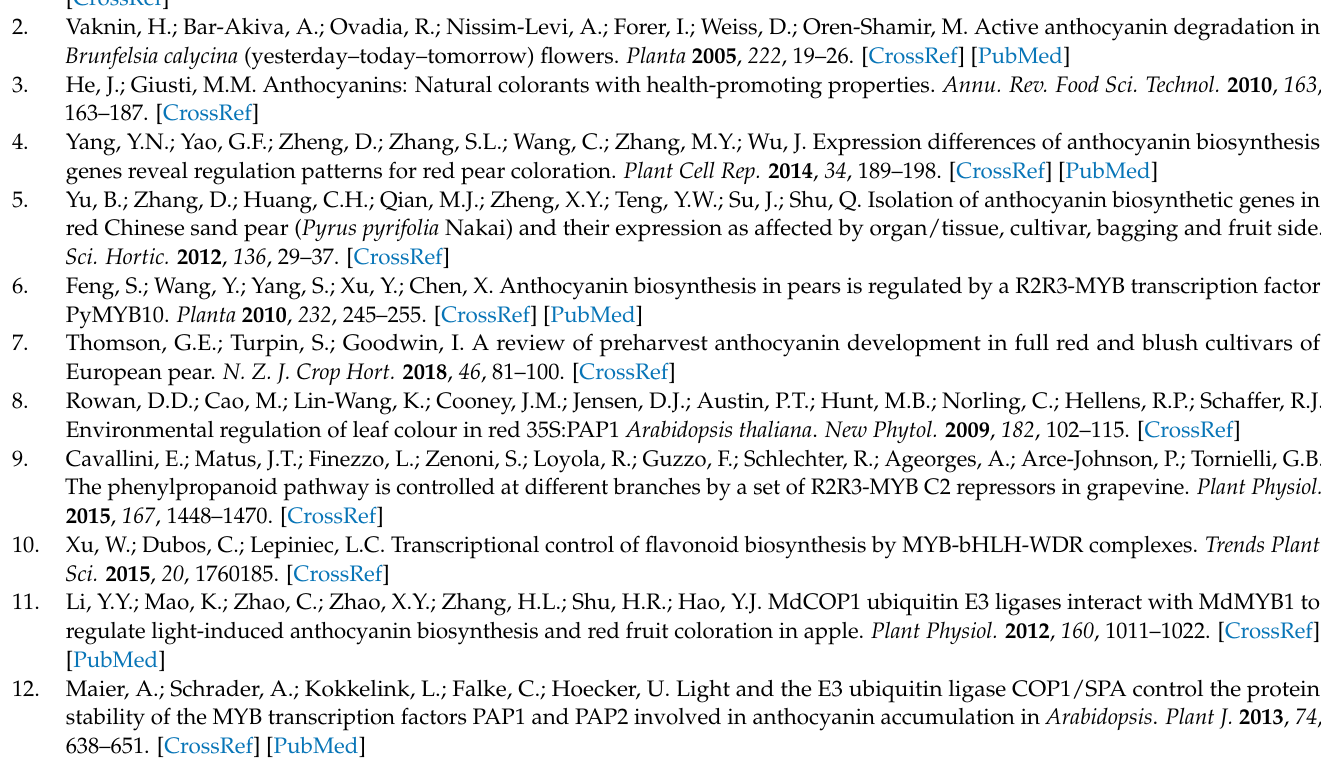
Table S5: Differentially expressed genes involved in the Gene—Light, Table S6: Statistics of RNA-Seq data.Table S7: List of qRT-PCR Primers. Figure S1: The relative expression of the anthocyanin biosynthesis-related structural